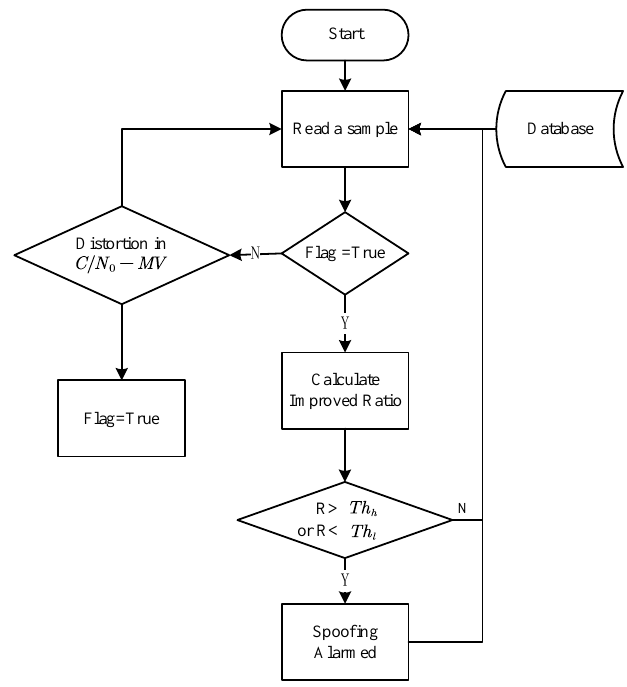
Figure 2. The operation flow of the detection software.